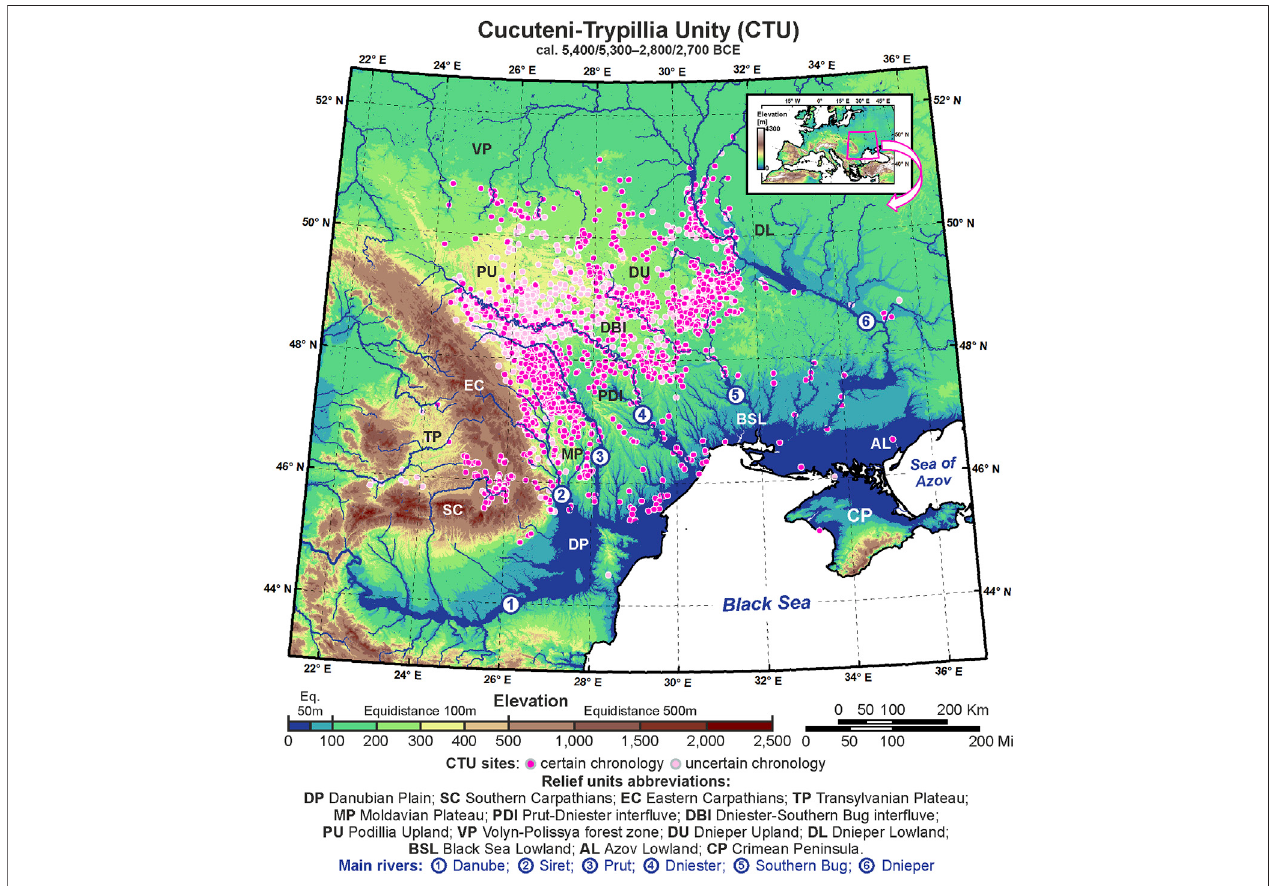
FIGURE 1 | Elevation in Eastern Europe and the distribution of Cucuteni – Trypillia cultural unity (CTU) sites; the relief units and major rivers are highlighted for the study area.